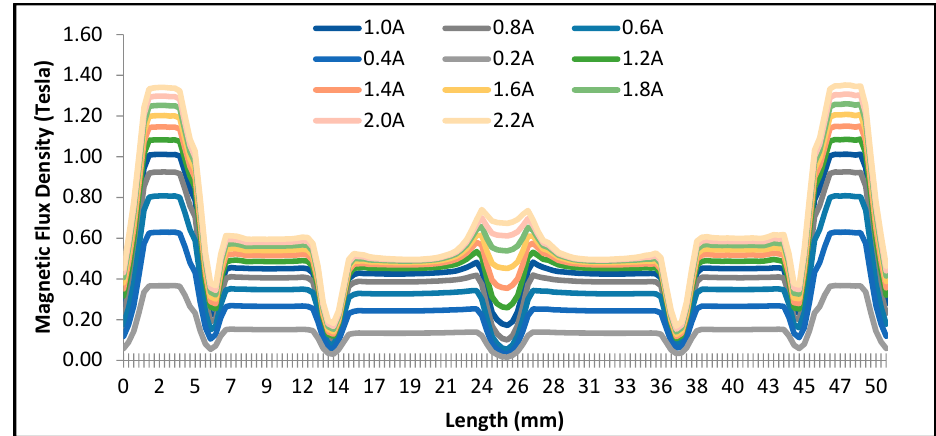
Figure 7. Magnetic flux density along the flow path of the serpentine valve.